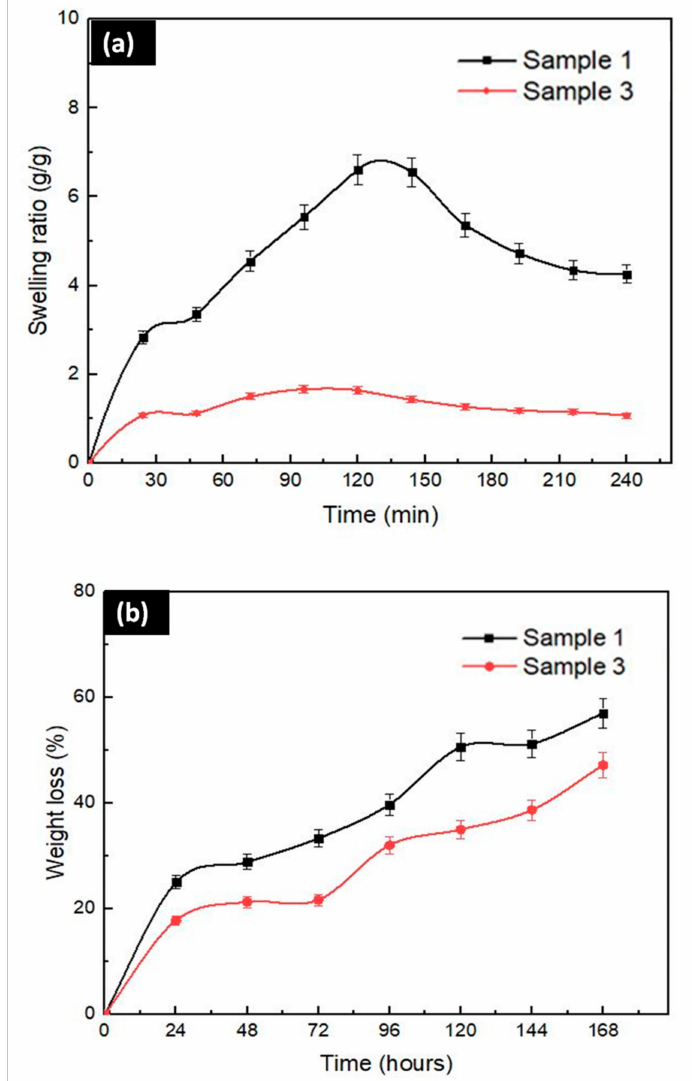
Figure 5. ( a ) Swelling and ( b ) degradation kinetics of 3D-printed Sample 1 and Sample 3 sca ff olds in PBS 7.4 at 37 ◦